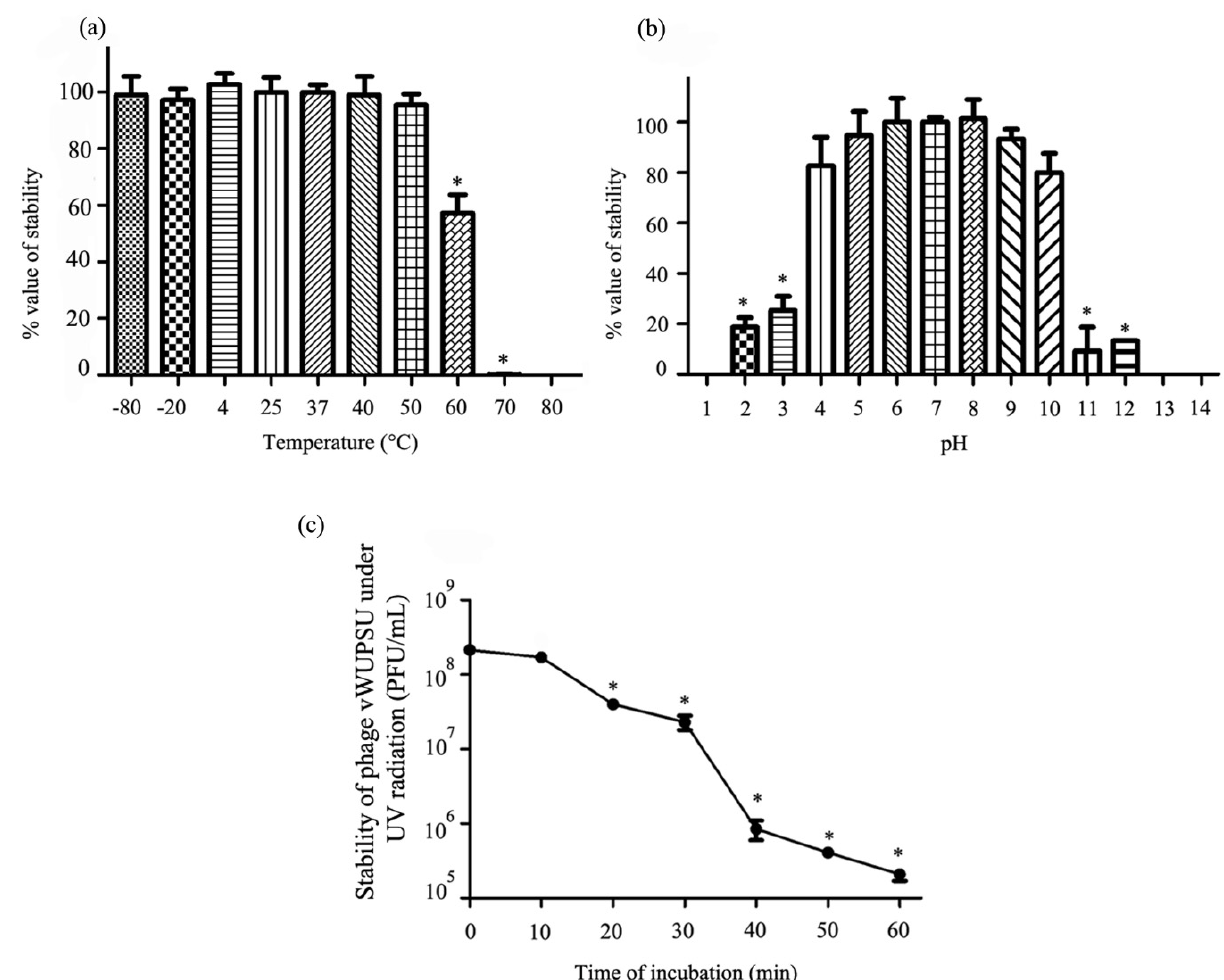
Figure 6. Stability of phage vWUPSU under varying conditions. ( a ) Effect of varying temperature phage vWUPSU stability; ( b ) stability of phages at varying pH at 37 ◦ C; ( c ) stability of phage under on phage vWUPSU stability; ( b ) stability of phages at varying pH at 37 °C; ( c ) stability of phage UV radiation. Experiments were undertaken independently in duplicate with duplicate assay. The data show mean ± SD (*, p value <